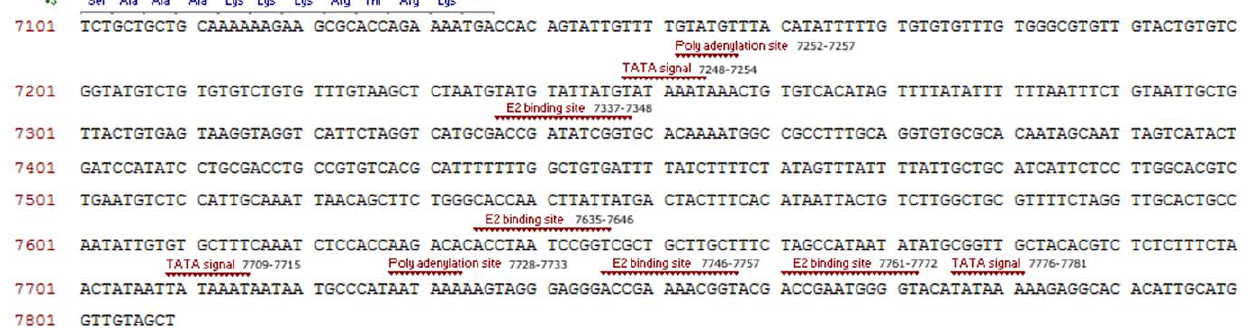
(Figure 2) and contains genes coding for five early proteins E6, E7, E1, E2 and E4 and two late capsid proteins L1 and L2. The genome of the HPV-125 also contains two non-coding regions; the classic non-coding long control region (LCR) located between the L1 and E6 genes (nucleotide positions 7,137–7,809, length 673-bp) and a second non-coding region located between genes E2 and L2 (nucleotide positions 3,757–4,216, length 460-bp). Typical features of the LCR of HPV-125 are shown in Figure 3. The percentage similarity of nucleotide and amino acid sequences of the six viral genes of HPV-125 shared by other HPV genotypes from Alphapapillomavirus species 2 is shown in